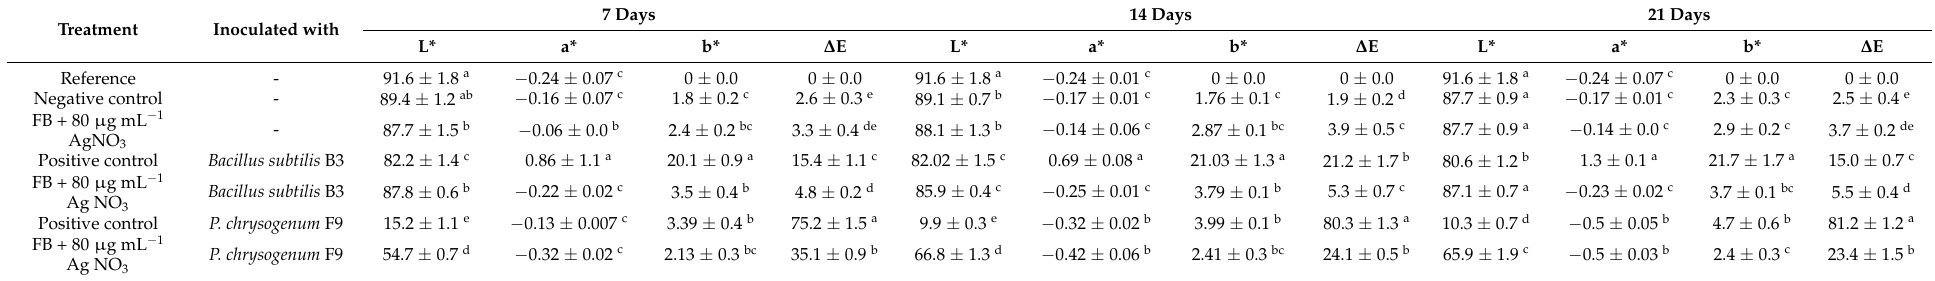
Table 2. Color changes measured according to CIE L*a*b* system using Ultra-scan PRO, UV spectrophotometer of filter papers treated with 80 µ g mL − 1 AgNO 3. Treatment Inoculated